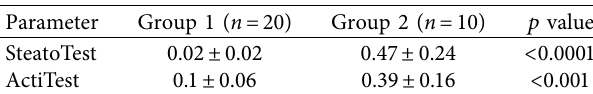
Figure 2: (a) Correlation of steatosis with age. (b) Correlation of liver stifness with age. Steatosis and liver stifness progress with age. p < 0.001. Table 2: Results of FibroMax.